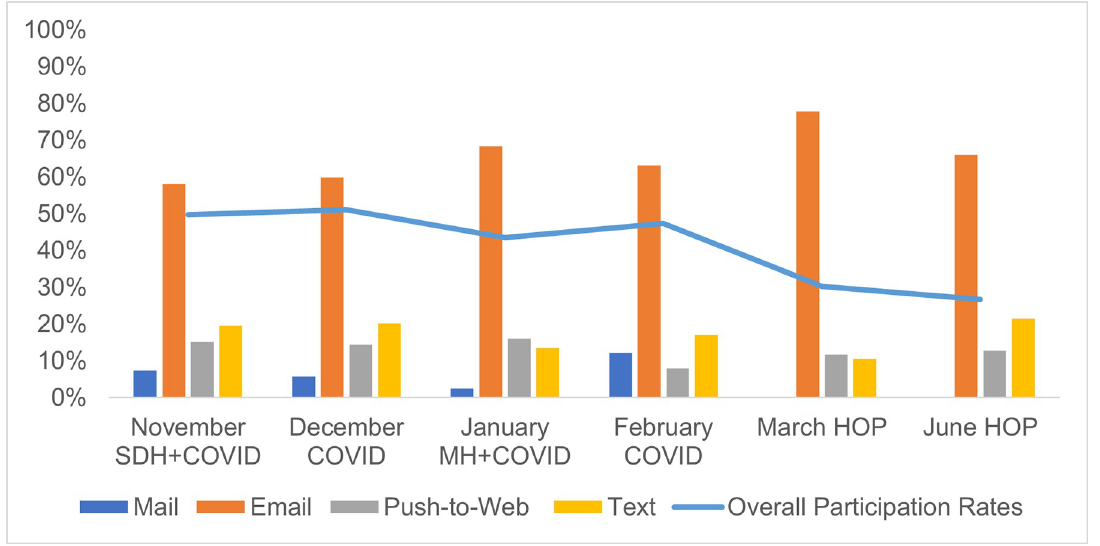
Fig 5. Percentage of invite mode that led to responses by month with overall response